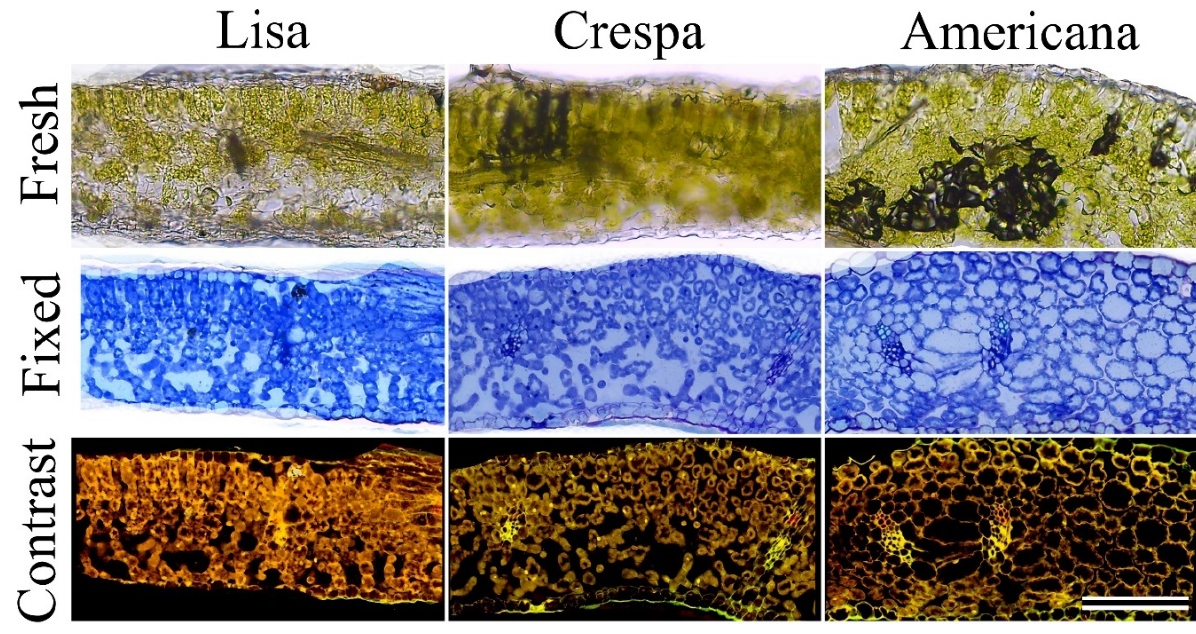
Figure 3. Microscopy of fresh leaf cross-section ( top ), historesin-fixed ( middle ), and phase contrast analysis ( bottom ) of representative leaves from Lisa, Crespa, Americana lettuce varieties. Scale bar = 150 µm. Table 1. Descriptive analysis of lettuce plants. Photosynthetic pigment content expressed by leaf area between Lisa, Crespa, and Americana lettuce varieties (Duncan’s test; p < 0.01) ( n = 600 ±